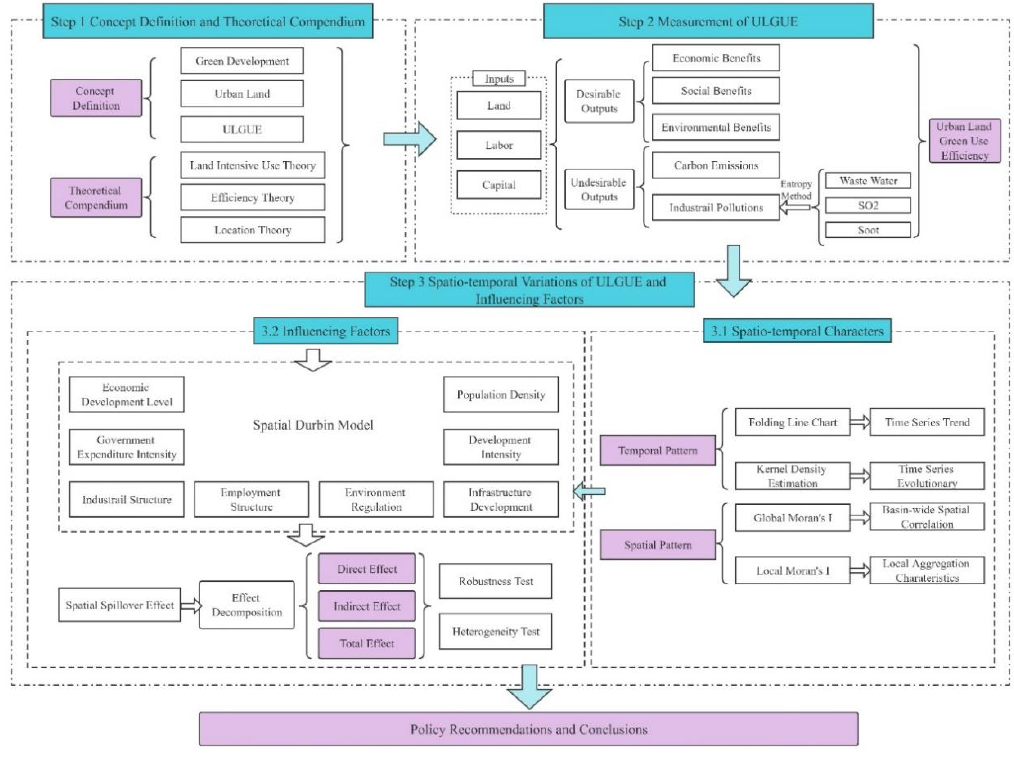
Figure 1. Research framework.